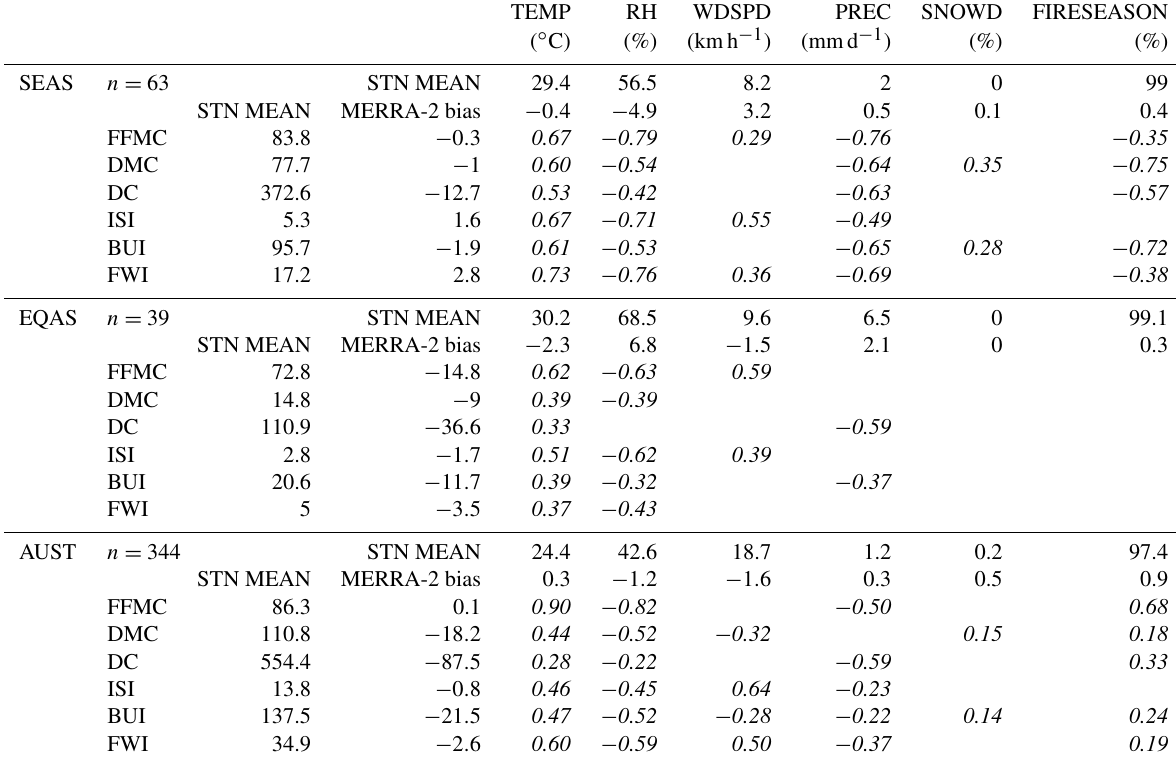
Table 5. Same as Table 2 but for the SEAS, EQAS and AUST